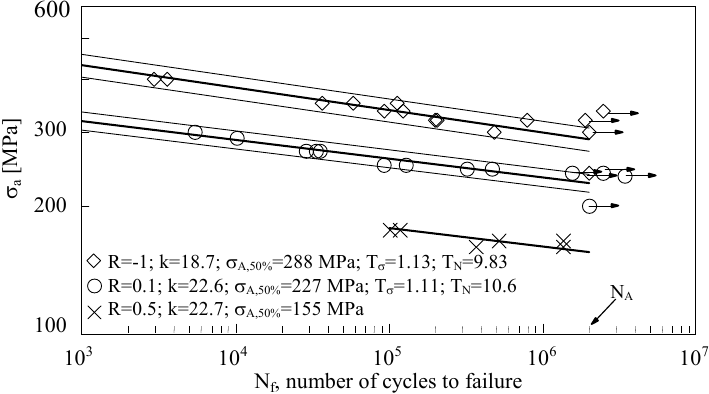
Figure 4: Fatigue data analysed in terms of engineering stress amplitude for different load ratios. Scatter bands are defined for 10% and 90% survival